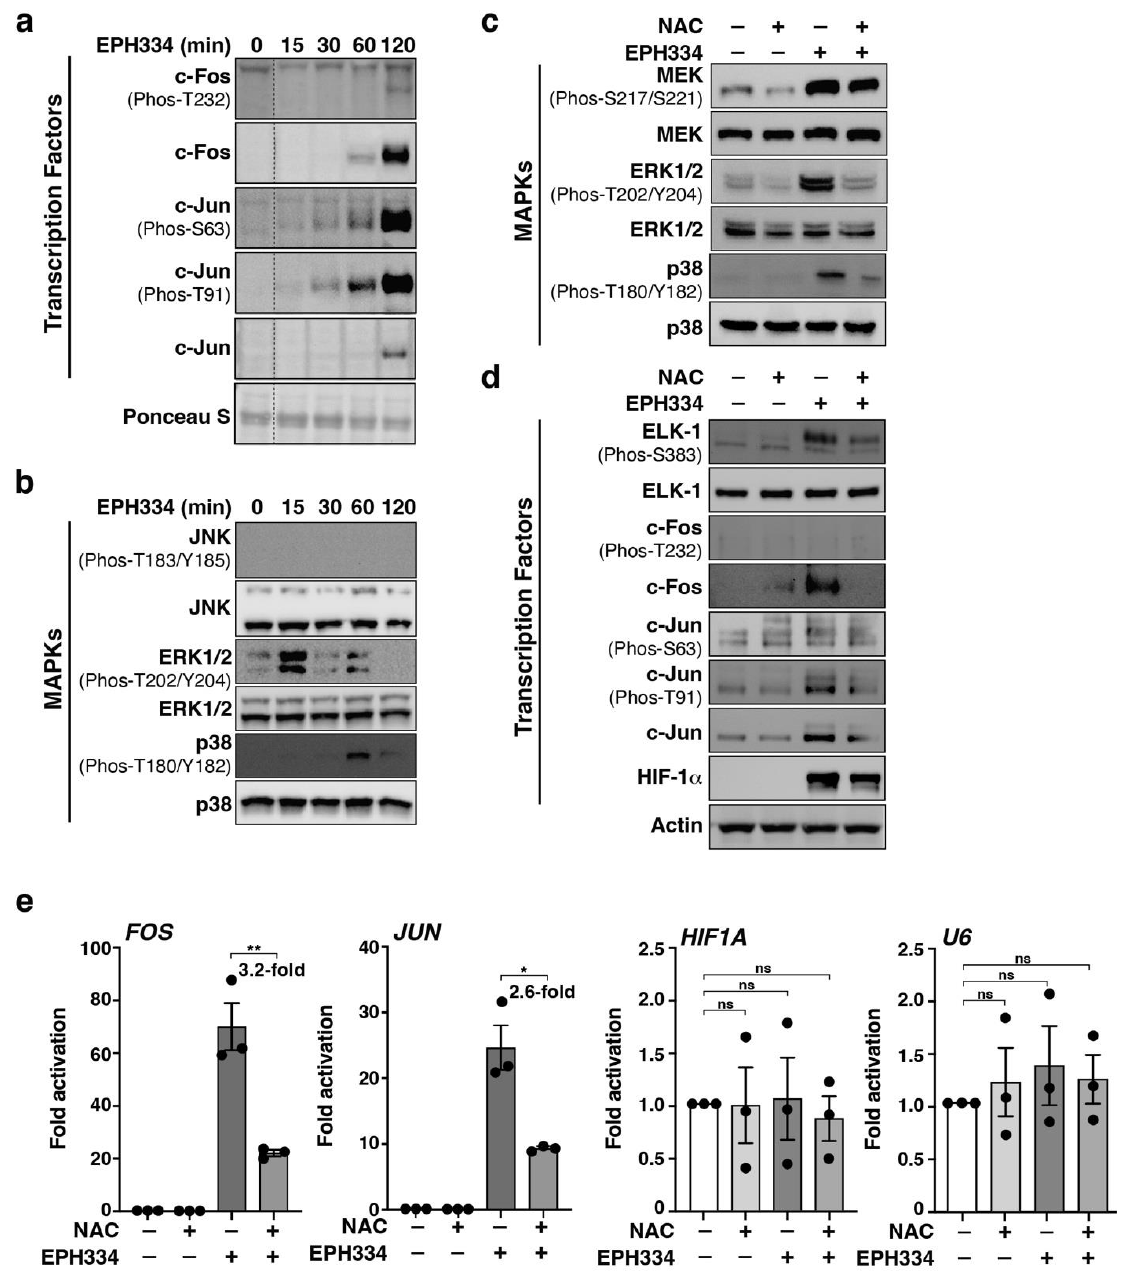
Figure 6. Pharmacologic inhibition of ROS generation blocks EPH334-mediated transcription factor induction and phosphorylation, thereby dampening latent HIV-1 reactivation. ( a , b ) Western blots of J-Lat 10.6 cells treated during a time course with EPH334 (2.5 μ M) and probed with the indicated antibodies. The dashed line in panel ( a ) indicates that the blot was cropped. Time zero was placed before the treatment. See original complete blot in Supplementary Figure S10. ( c , d ) Western blots of J-Lat 10.6 cells pretreated for 2 h with NAC (10 mM) or vehicle control (tissue culture media) and then treated for 15 min (for the MAPKs) or 8 h (for the transcription factors) with EPH334 (2.5 μ M) or vehicle control (DMSO) and then probed with the indicated antibodies. ( e ) RT-qPCR assays of J-Lat 10.6 cells pretreated for 2 h with NAC (10 mM) or vehicle control (tissue culture media) and then treated for 8 h with EPH334 (2.5 μ M) or vehicle control (DMSO). Quantitation of the indicated RNAs was normalized to RPL19 by RT-qPCR (mean ± SEM; n = 3). p -values (* p < 0.05, ** p < 0.01, *** p < 0.001, ns = not significant) were determined by unpaired Student’s t test. p < 0.05 was considered statistically significant.